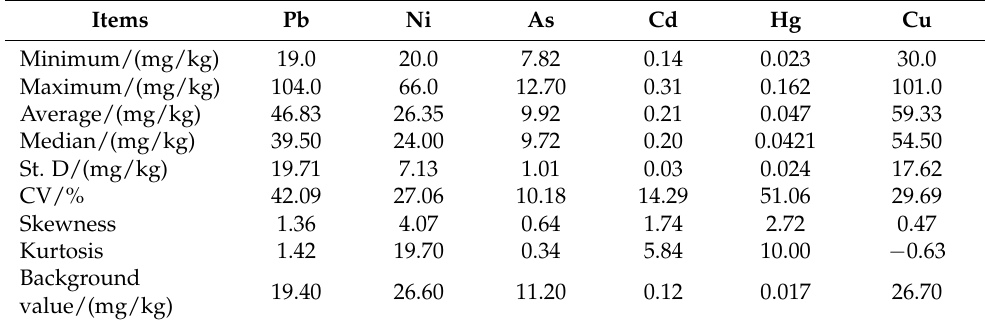
Table 3. Descriptive statistics of heavy metals concentrations in urban surface dusts ( n = 52).